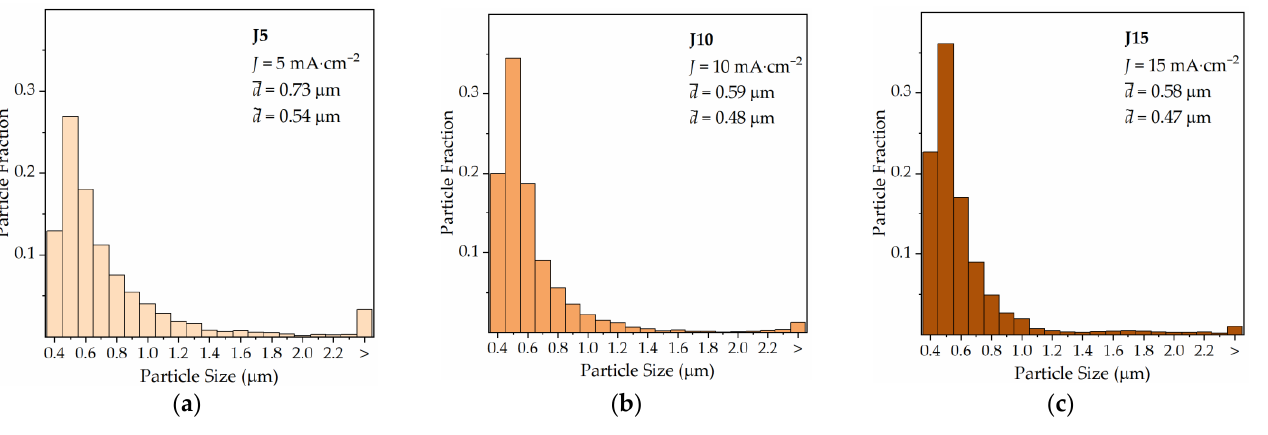
Figure 5. Particle size distribution for current densities of 5 ( a ), 10 ( b ), and 15 mA·cm −2 ( c ) at 900 mC, without electrolyte agitation. Only particles larger than 370 nm were measured and considered for descriptive statistics analysis.